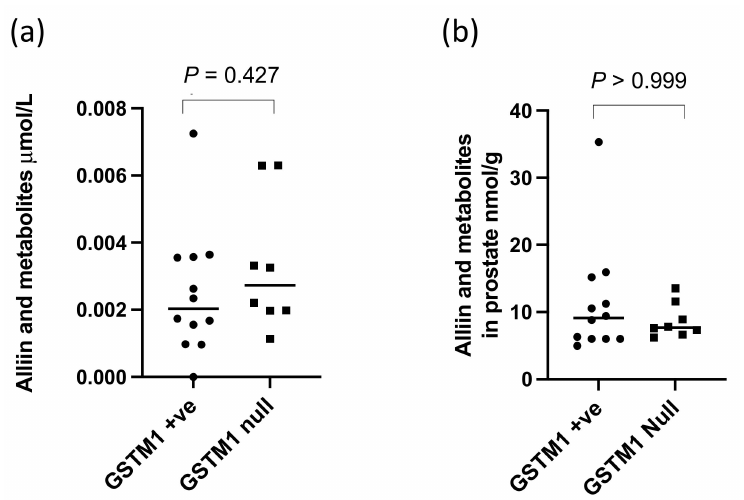
Figure 8. Alliin and associated metabolites in ( a ) PZ, ( b ) PZ with outliers removed, and ( c ) TZ. p -values are from Mann–Whitney tests in prostate following consumption of alliin supplements or not (control).